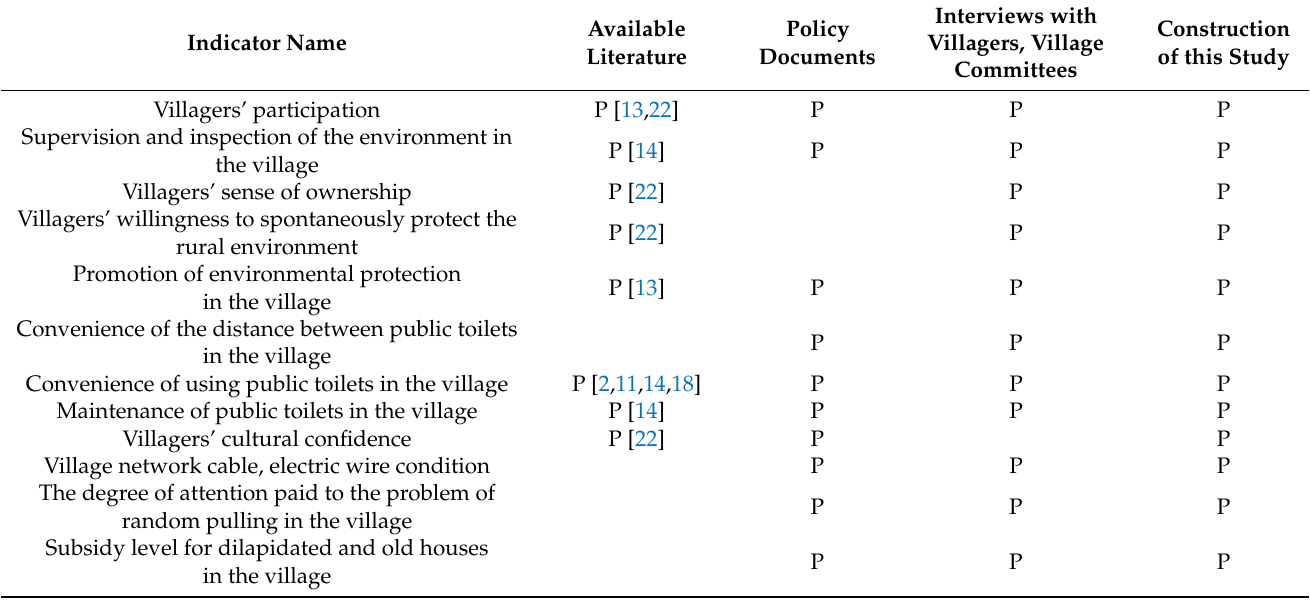
Table 1. Basis of selection of